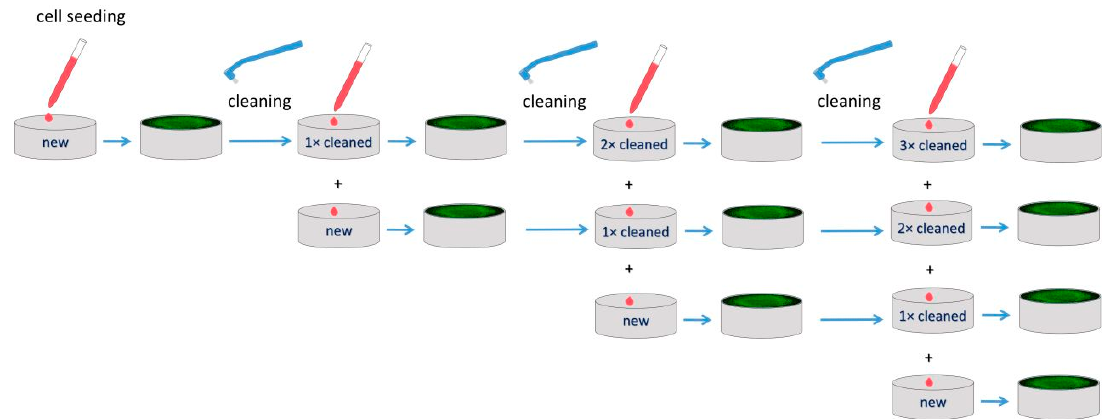
Figure 1. Scheme of the experiment: cell seeding on new as well as repeatedly cleaned titanium samples.